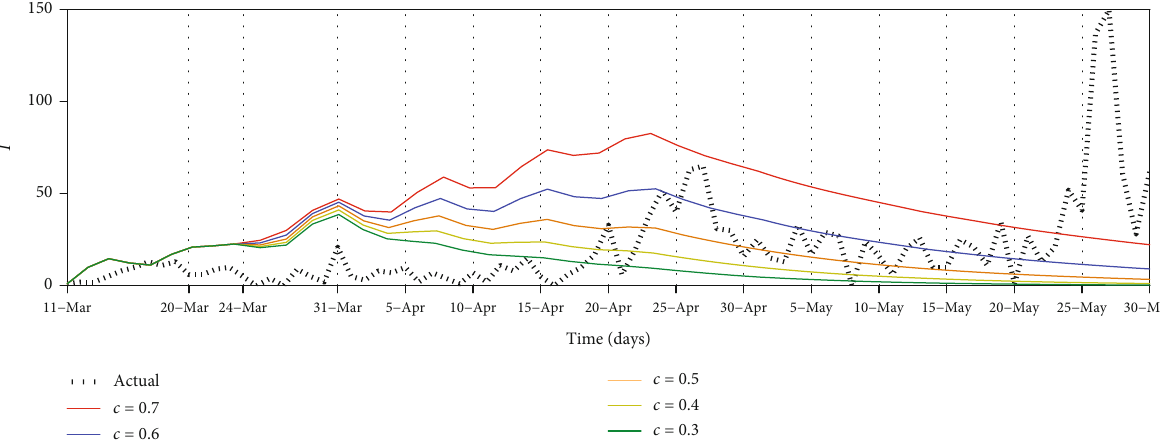
Figure 6: Comparison of actual infected data and simulation results for di ff erent contact rate values in Sri